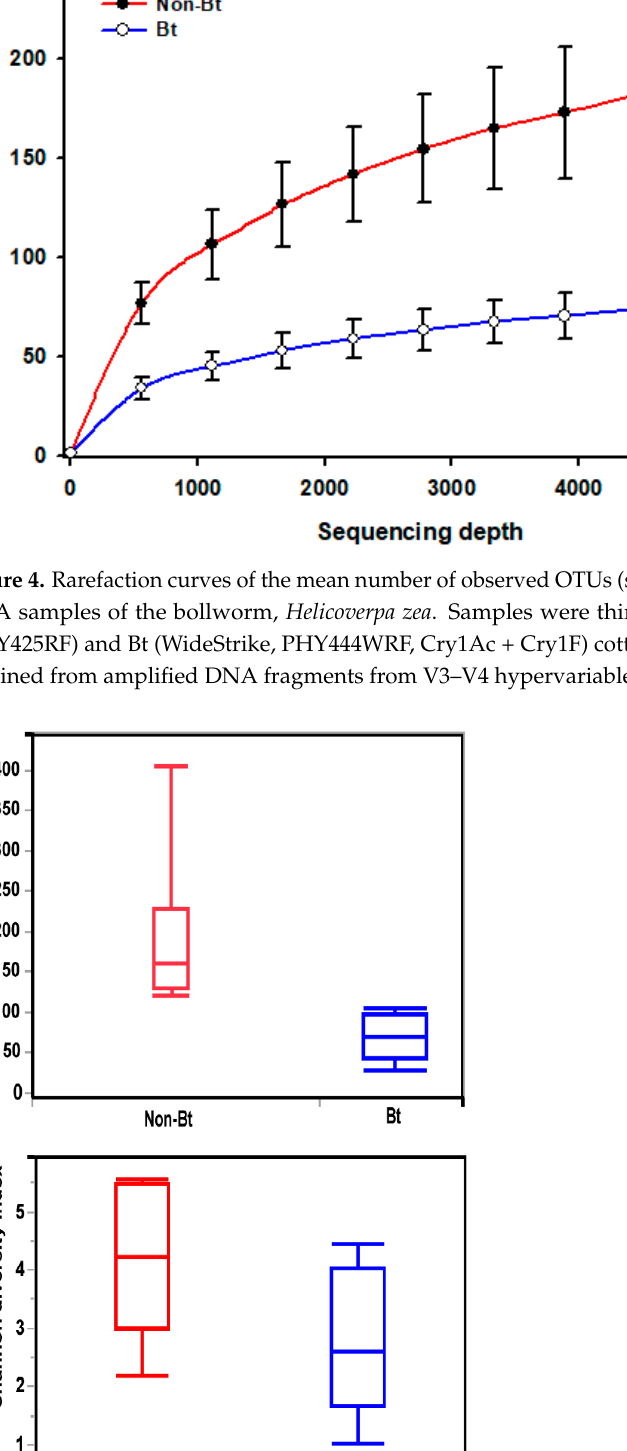
Figure 6. Principal coordinate analysis of bacterial composition of third stadium bollworms Heli- coverpa zea collected from non-Bt cotton and Bt (WideStrike) in season 2. Analysis is based on the weighted Unifrac metric.